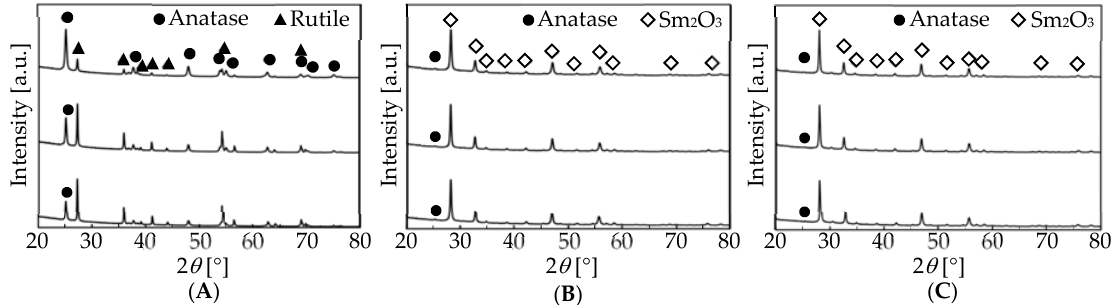
Figure 4. XRD of ( A ) TiO 2 , ( B ) 5 wt.% TiO 2 + Sm 2 O 3 , and ( C ) 5 wt.% WO 3 / Sm 2 O 3 . Upper—before the reaction. Middle and lower—after the reaction without and with UV ‐ LED.